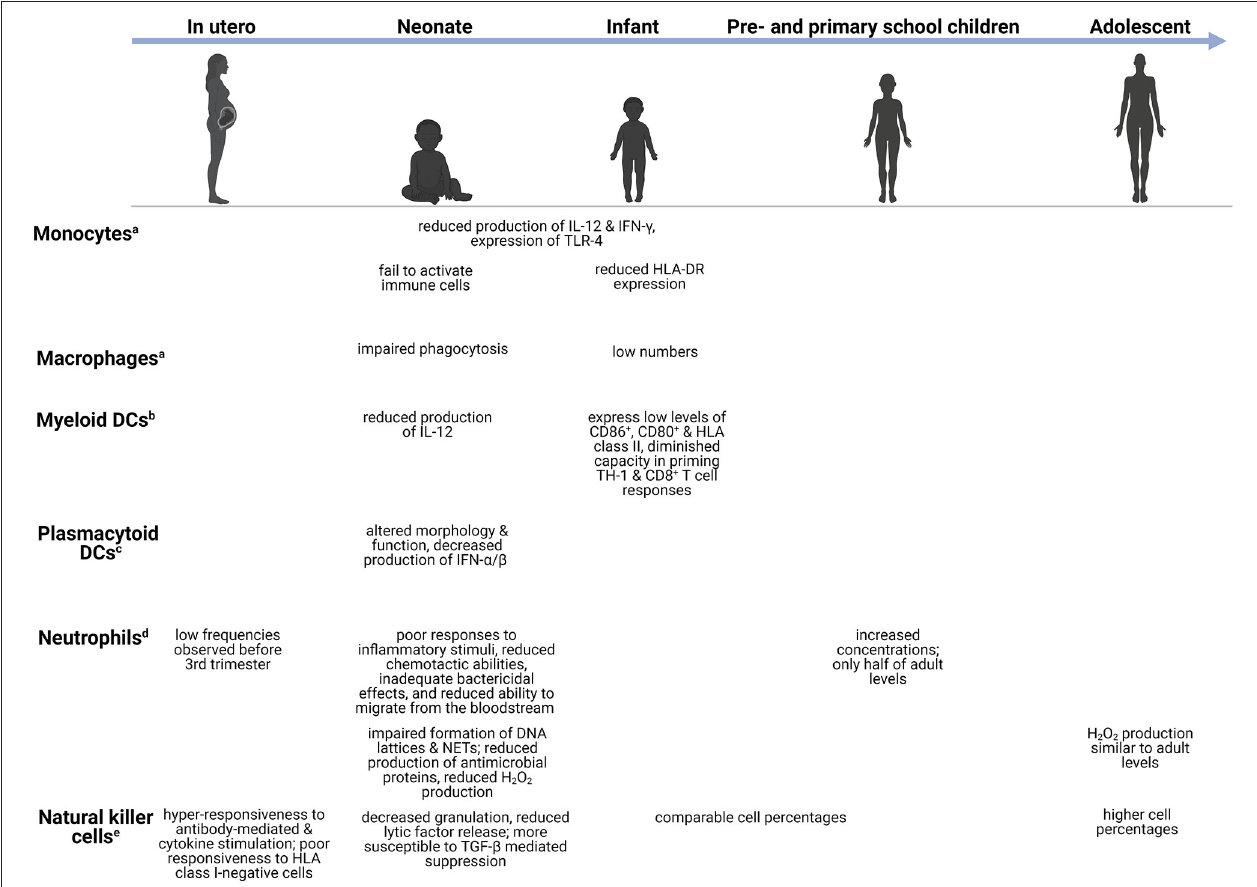
FIGURE 1 | Age-dependent differences in the innate immune system. Changes in the innate immune cells during development, from in utero (week 27–birth), neonate (infants in the first 28 days after birth), infants (0–1 years), preschool children (1–6 years), primary school children (6–12 years), to adolescents (12–18 years). a Monocytes/macrophages-capable of phagocytoses and production of pro-inflammatory cytokines ( 18). b Myeloid DCs-potent initiators of TH1-mediated responses ( 19). c Plasmacytoid DCs-act as antigen presenting cells and regulate T cell responses (19). d Neutrophils-release antimicrobial peptides and produce reactive oxygen species ( 20, 21). e Natural killer cells-release granzyme B and perforin (22). CD, cluster of differentiation; DC, dendritic cell; DNA, deoxyribonucleic acid; HLA-DR, human leukocyte antigen-DR; H 2 O 2 , hydrogen peroxide; IL, interleukin; IFN, interferon; NET, neutrophil extracellular trap; TGF- β , transforming growth factor β ; TH, T-helper; TLR, toll-like